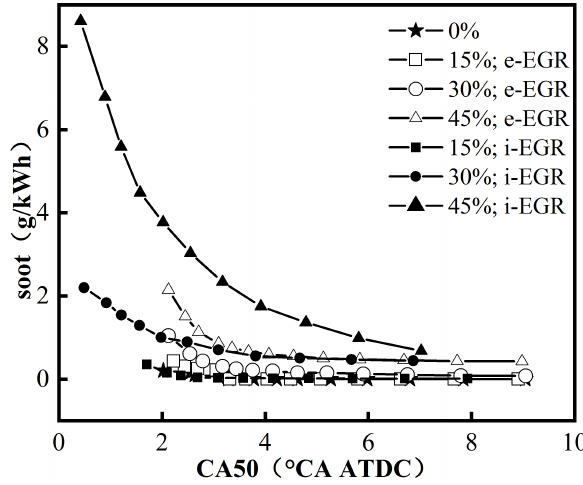
Fig. 10 Effects of CA50 and EGR ratio on soot emission.